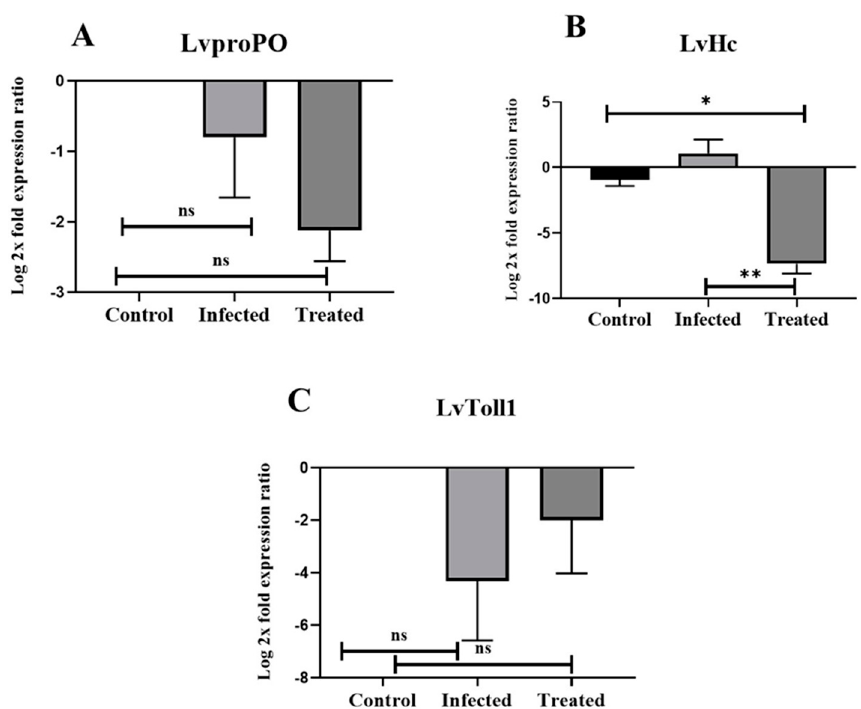
Figure 9. Relative qPCR expression analysis of the LvproPO ( A ), LvHc ( B ), and LvToll1 ( C ) genes in the hepatopancreas of Litopenaeus vannamei in the control, infected, and treated groups. Data are normalized to β -actin. The data were analyzed by a one-way ANOVA and presented as a fold change between groups. Values are expressed as the mean ± SE (n = 3 per group). Asterisks refer to significant differences between groups at * p < 0.05, ** p < 0.01, and ns: non-significant.